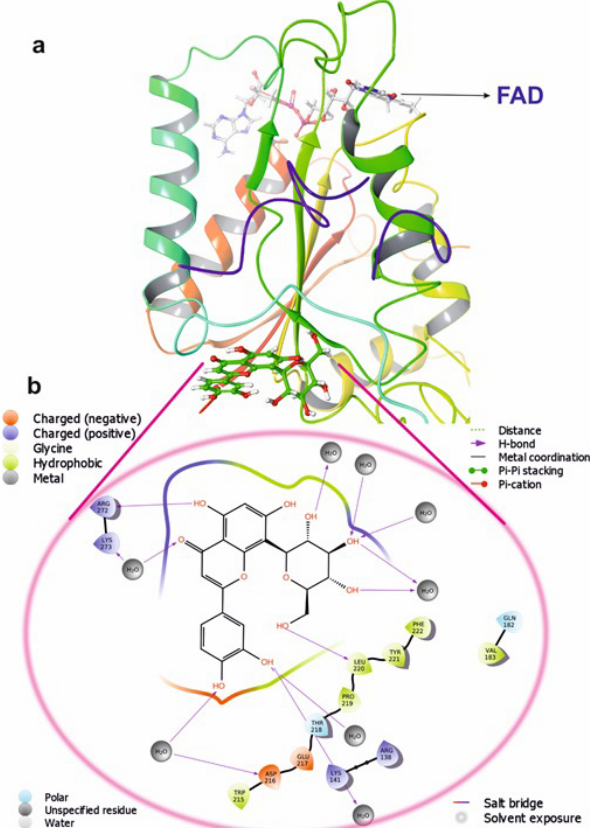
Figure 10. The putative binding pose of Orientin with NQO1: ( a ) Orientin represented in green can be seen deeply embedded into the active site. ( b ) The two-dimensional geometrical pose of Orientin interacting with surrounding amino acids at the putative binding cavity of